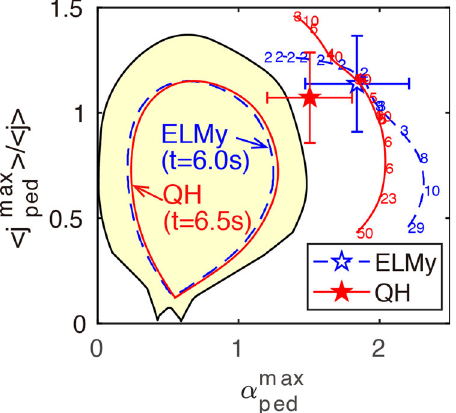
Fig. 4 MHD stability diagrams of the ELMy (high-con fi nement mode with edge-localized-mode evaluated at t = 6.0 s) and QH (quiescent high- con fi nement mode evaluated at t = 6.5 s) phases in E042868. The stability analysis was performed for ideal MHD modes with toroidal mode numbers ranging from 1 to 50. When setting the boundary conditions, the JT-60U vacuum vessel was assumed as an ideal conducting wall. Here, the normalized pedestal current ( j ped. max /<j>) is plotted against the normalized Fig. 5 Radial pro fi les of the QH-mode phase. a Pressure and safety factor, pressure gradient ( α ped. max ) at the pedestal, showing the MHD equilibria. b pedestal current and linear eigenfunction of the unstable The small numbers associated with the curves correspond to the toroidal peeling – ballooning mode obtained with the MARG2D code, c normalized mode number of the most unstable kink, peeling, or ballooning modes for electron-temperature fl uctuations measured by the electron – cyclotron- several locations in the normalized pedestal current ðh j max ped i = h j iÞ and emission (ECE) diagnostic for the fundamental component of edge- pressure-gradient ð α max ped Þ space. The error bars for ELMy (blue star)/QH harmonic oscillations (1f EHO ) and the product of the poloidal Fourier (red fi lled star) operation points represent compound errors that result components ( n = 2) of the linear eigenfunction, R e ( ξ r ) (obtained with the from propagation of the uncertainties in estimating the pedestal current ideal MHD code MARG2D) times the inverse gradient scale length, and pressure gradient. difference between the ECE and the magnetic diagnostics (saddle coil). illustrated in Fig. 6a. The oscillation amplitude is the same as that : ~ of T Env at the LFS, as can be seen in the 1f EHO envelope signals for discharge E042868 ( t = 6.325 – 6.565 s), mapped onto t he single-time e from both the FIR-U1 (HFS) and the FIR-U2 (Top/Bottom) data equilibrium at t = 6.5 s as a function of distance from the separatrix (R- at almost the same frequency (~ f envelope ), as shown in Fig. 6b and R SEP ) at the low- fi eld mid-plane of the d. The most crucial point is that the same oscillation at the fre- quency ~ f envelope can be seen in the “ mean ” temperature gradient, (cid:3) Δ ~ T ECE = Δ R ECE , as shown in Fig. 6c and d. Here, the ∇ ~ T Mean e e ~ values of Δ T ECE are obtained by subtracting the ECE data at R e − 1 cm from that at R − R − 4 cm ( Δ R ECE = 3 cm) − R SEP ~ SEP ~ and applying a bandpass fi lter over the frequency range f BPF = 100 − 300 Hz.